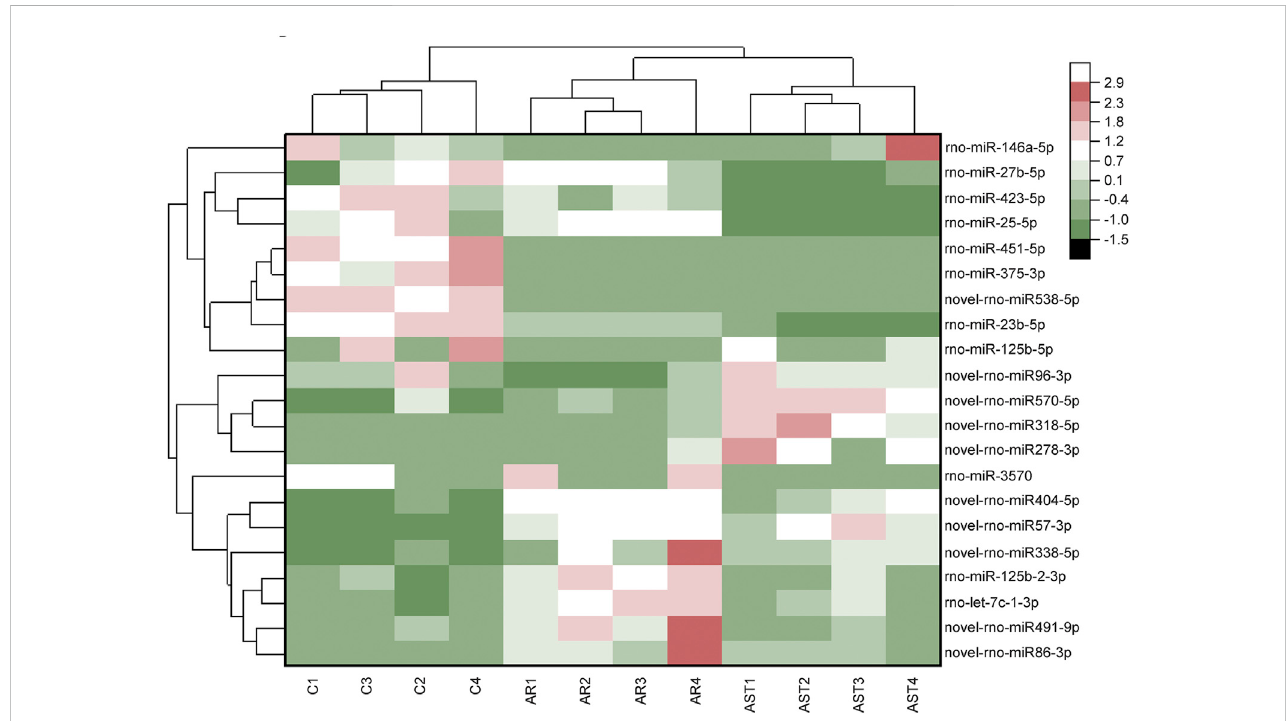
FIGURE 5 RNA-Seq-based differential microRNA heat maps were plotted against the expression level of each